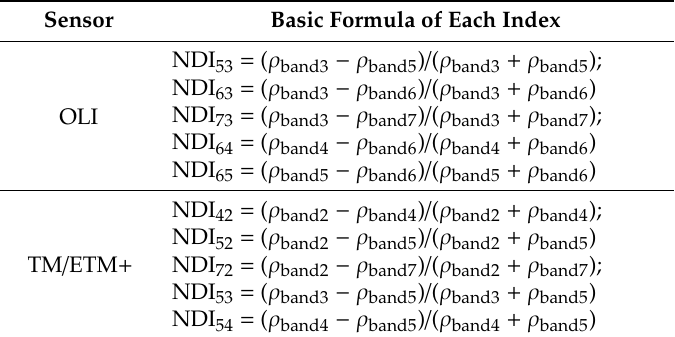
Table 2. Definition of each index (NDI is normalized di ff erence index; ρ band x is the reflectance of the x th